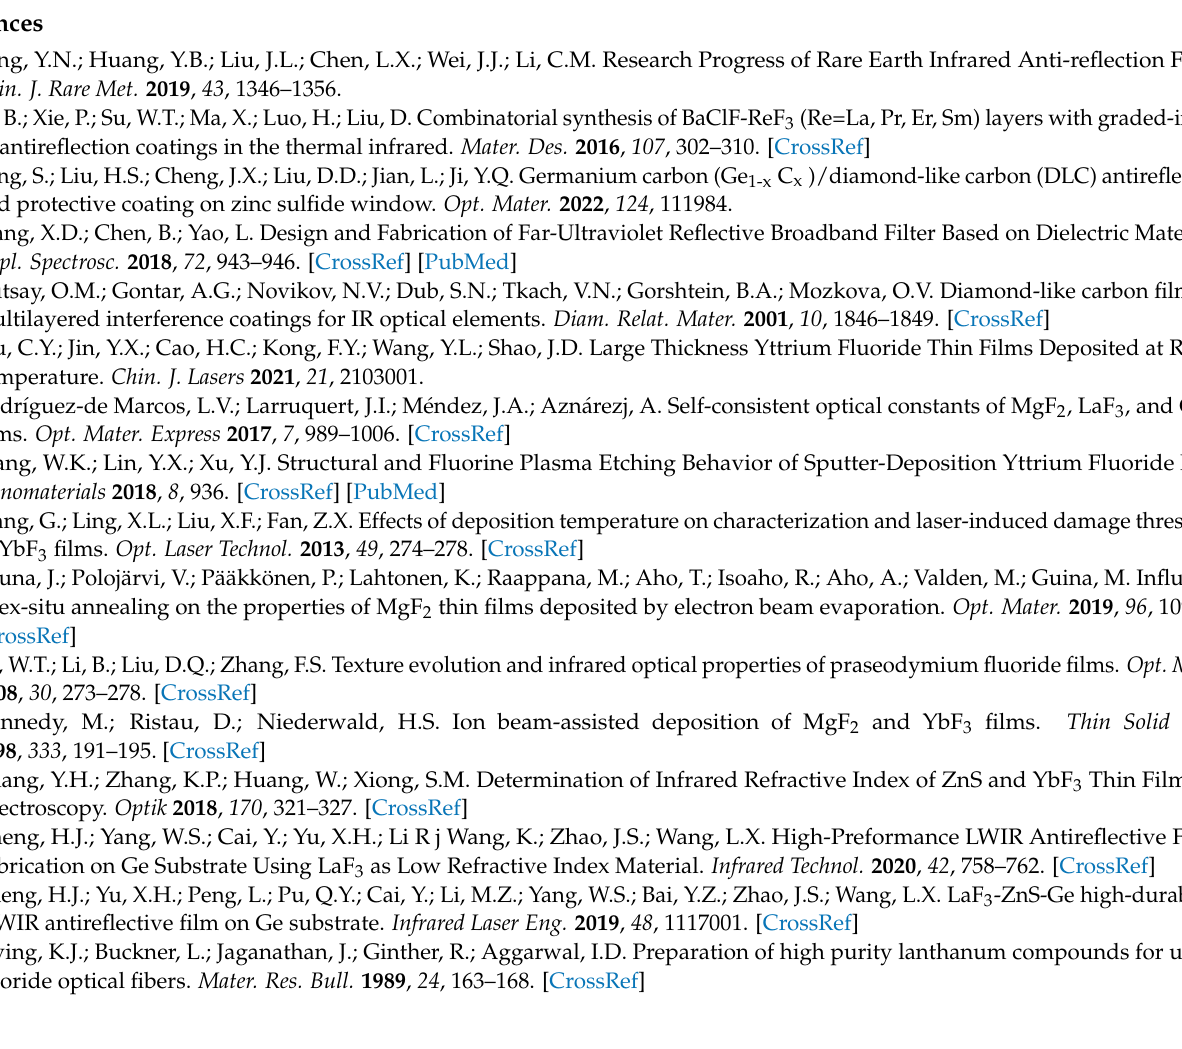
in Ge/ LaF3-5 thin films, O/F ratio is 0.055; Figure S7: XRD patterns of the Ge/LaF3-1(13.33 at.%) thin film; Figure S8: XRD patterns of the Ge/LaF3-3(9.60 at.%) thin film; Figure S9: XRD patterns of the Ge/LaF3-5(8.99 at.%) thin film; Figure S10: XRD patterns of the Ge/LaF3-4(8.30 at.%) thin film; Figure S11: XRD patterns of the Ge/LaF3-5(4.84 at.%) thin film; Table S1: LaF3 crystal raw materials with different oxygen content; Table S2: The O atomic percentage and O/F atomic ratio of LaF3 thin films; Table S3: The peak transmission and average transmittance of LaF3 films on Ge substrate with different oxygen contents; Table S4: The refractive index and extinction coefficient of LaF 3 films on Ge substrate with different oxygen